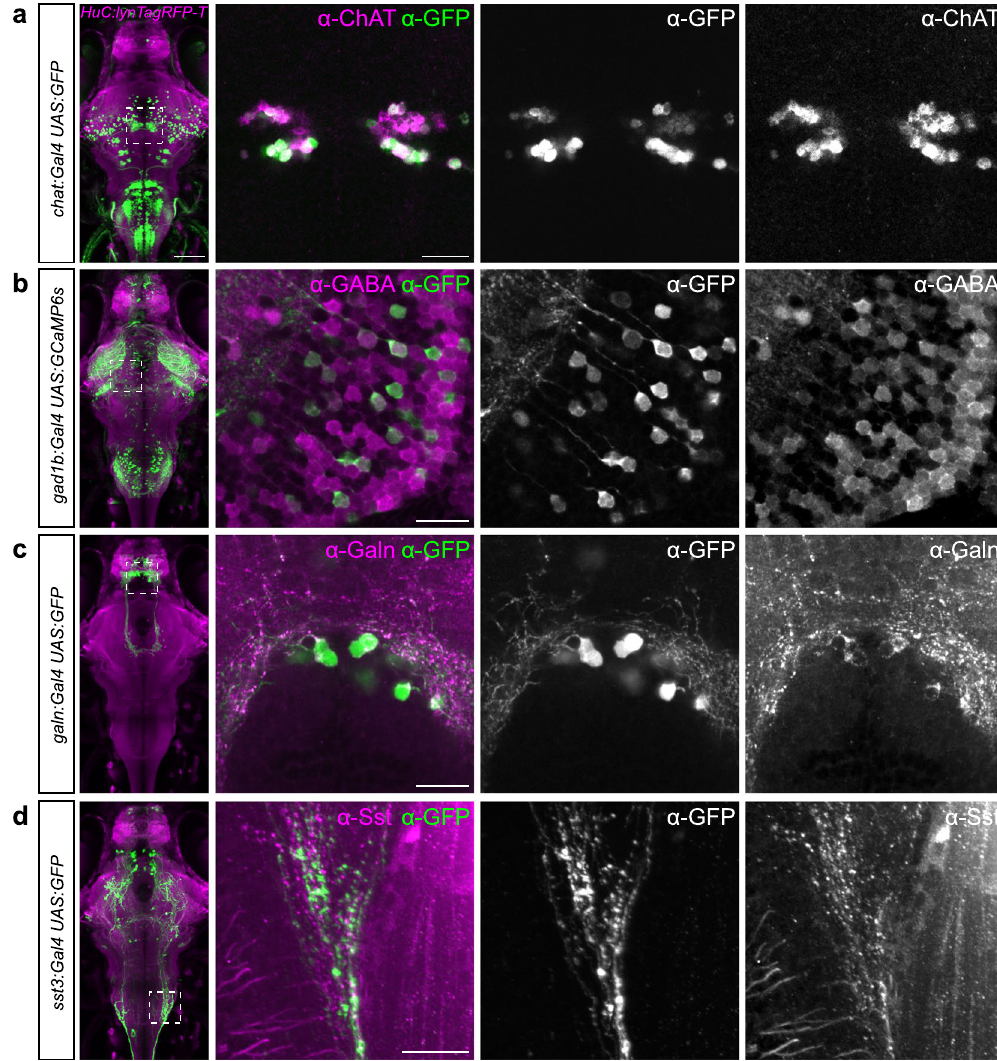
Figure 2. New transgenic lines largely recapitulate endogenous gene expression. ( a – d ) Antibody stainings of 6 dpf old larvae against GFP (green) and ChAT ( a ), GABA ( b ), Galanin ( c ) or Somatostatin ( d ), respectively (magenta). Genotypes are indicated on the left. Whole-brain images on the left show live expression pattern (lynTagRFP-T in magenta), outlining the location of the magnified regions on the right. Scale bar, 100 µ m for overview, 20 µ m for magnified